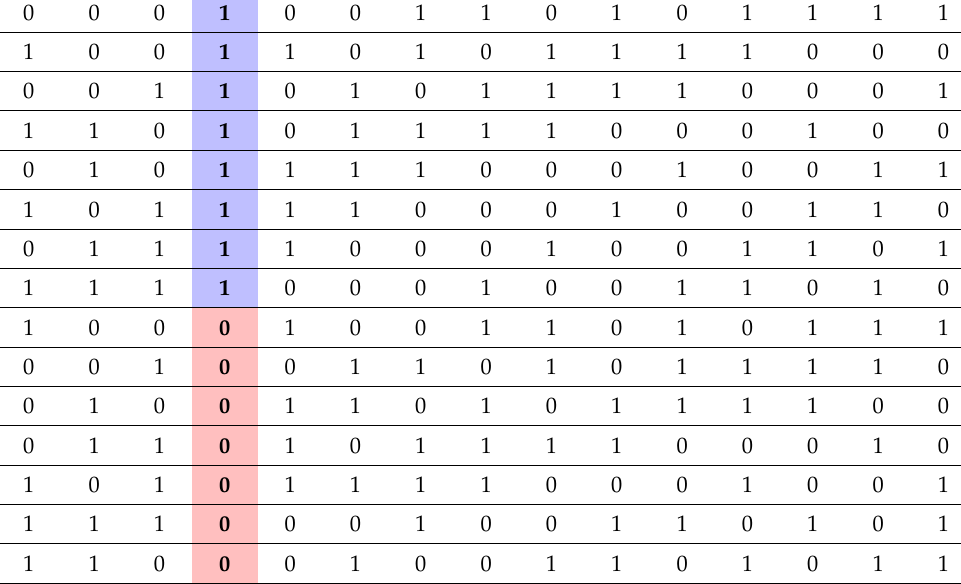
Table 1. Each row shows the sequence of 2 4 − 1 bits Y 3 ( c ) generated by a 4-bit ALFSR whose initial seed is selected randomly. The 4th column enlightens the presence of long sequences of 0 or